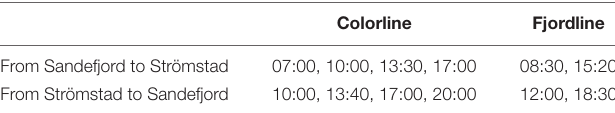
TABLE 1 | Departure times of the two ferry companies that sail between Sandefjord and Strömstad, 2020. Colorline